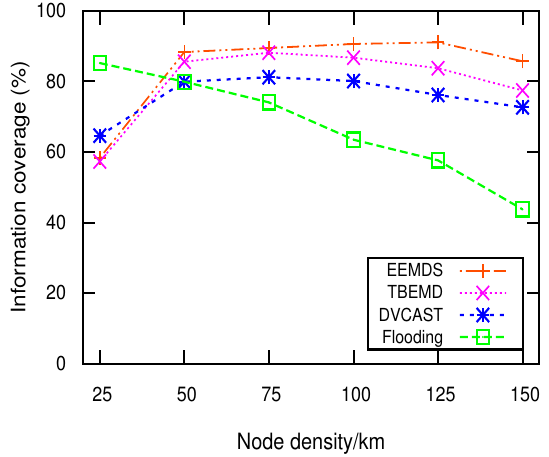
Figure 3. Information coverage vs. node